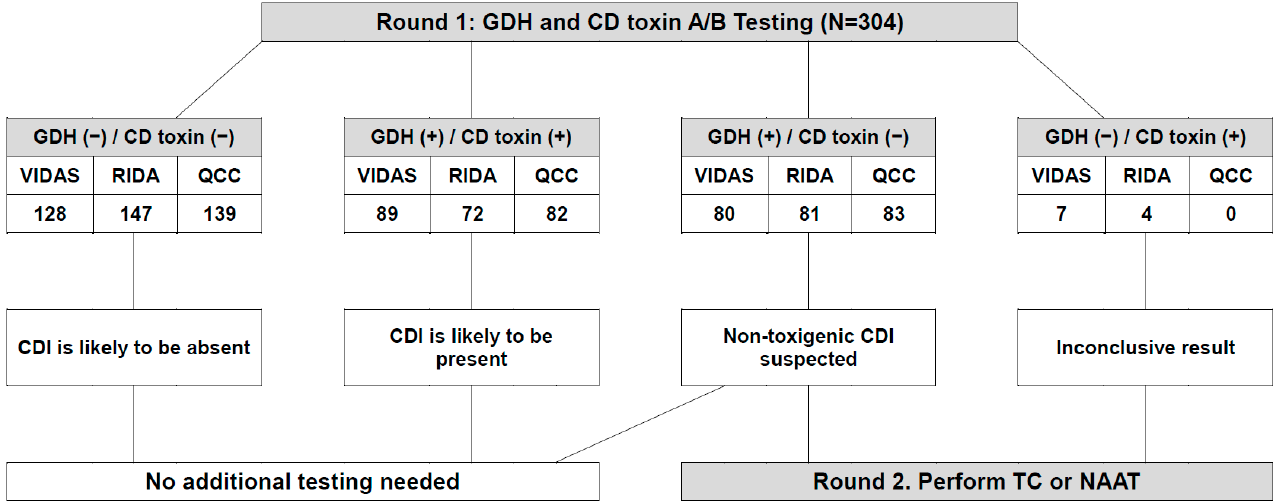
Figure 1. Two-round workflow for the diagnosis of toxigenic Clostridioides difficile infection by applying GDH and CD toxin A/B testing. Abbreviations: GDH, glutamate dehydrogenase; CD, Clostridioides difficile ; ( − ), negative; (+), positive; VIDAS, VIDAS C. difficile GDH and toxin A&B; RIDA, RIDASCREEN C. difficile GDH and toxin A/B; QCC, C. DIFF QUIK CHEK COMPLETE; CDI, Clostridioides difficile infection; TC, toxigenic Clostridioides difficile culture; NAAT, nucleic acid amplification test.